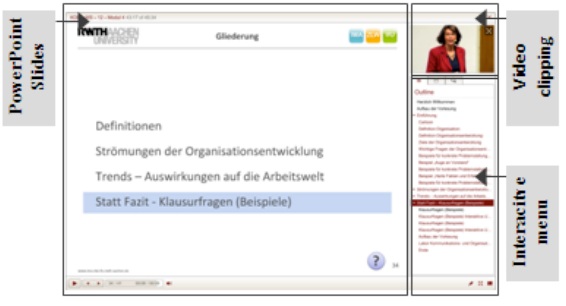
Figure 4. Surface of the video recording of the